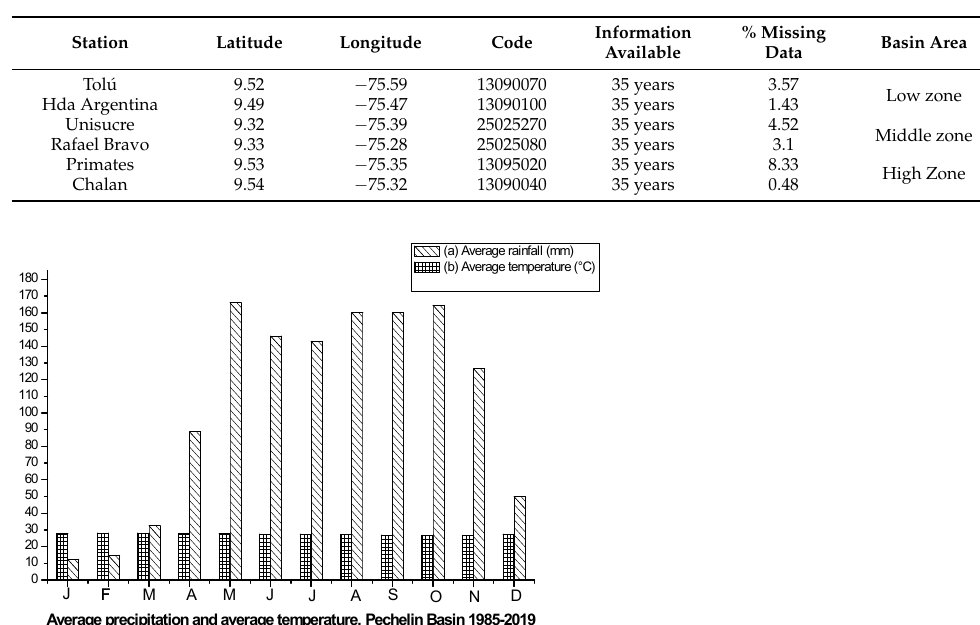
Figure 2. Characterization of the Arroyo Pechelín watershed: (a) (>250 m) high zone; (b) (100–250 m) middle zone; ( c ) (0–100 m) low zone. Table 2. Stations in the study basin’s high zone, middle zone and low zone.